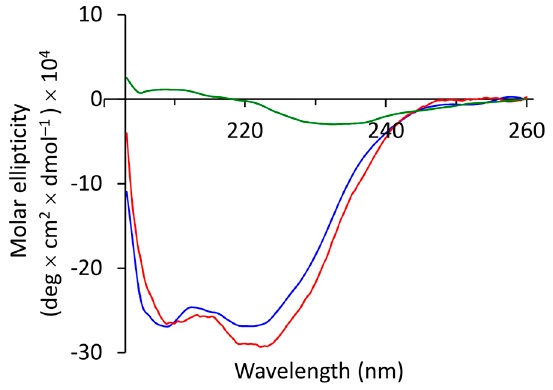
Figure 1. CD spectra of TB peptide analogs. CD spectra of TB_KKG6K (blue), D-Lys_TB_KKG6K (red) and TB_KKG6K scrambled (green), acquired in 10 mM PBS/10 mM SDS (pH 7.4). Table 1. Inhibitory concentrations (IC 90 , in µ M) of the TB peptide analogs against microorganisms §